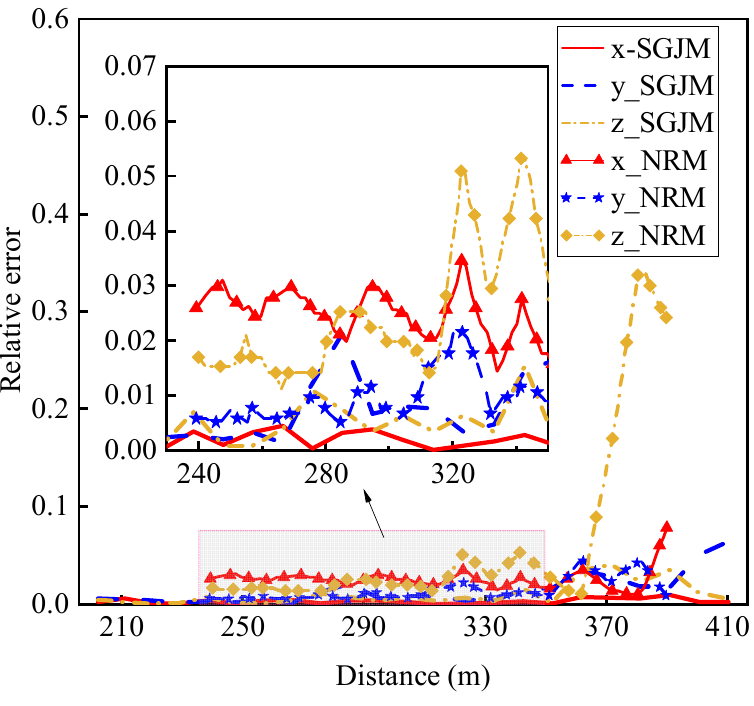
Figure 13. Comparison of RE between NRM and SGJM.